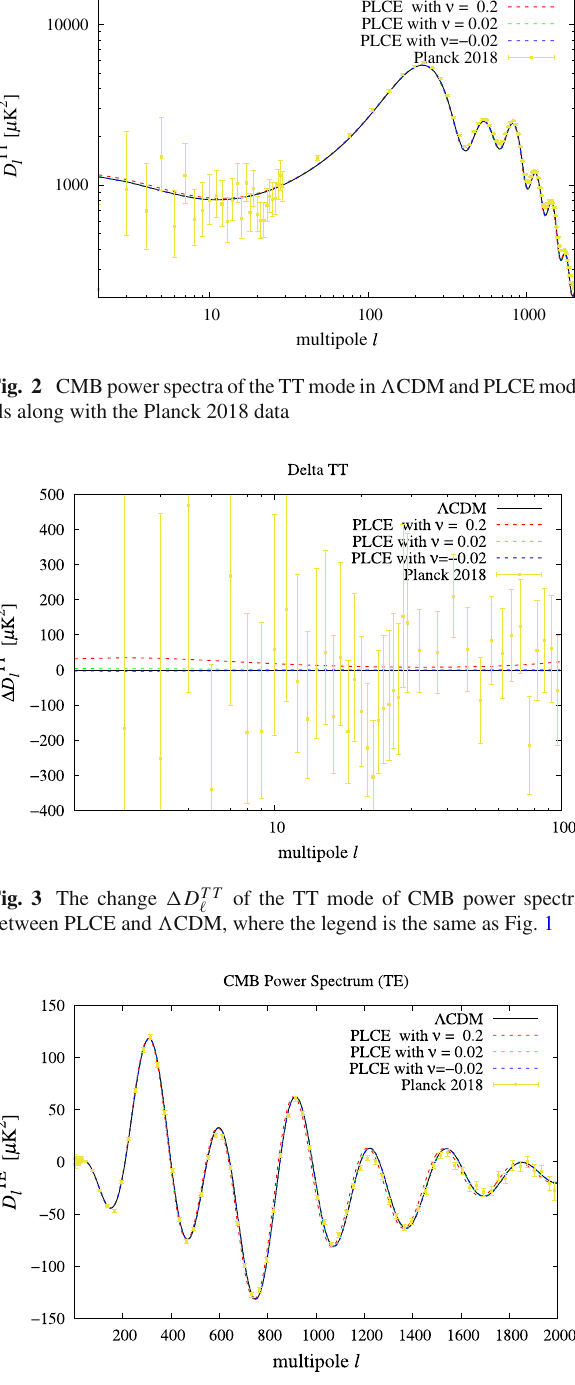
Fig. 4 CMB TE power spectra in the (cid:2) CDM and PLCE models along with the Planck 2018 data